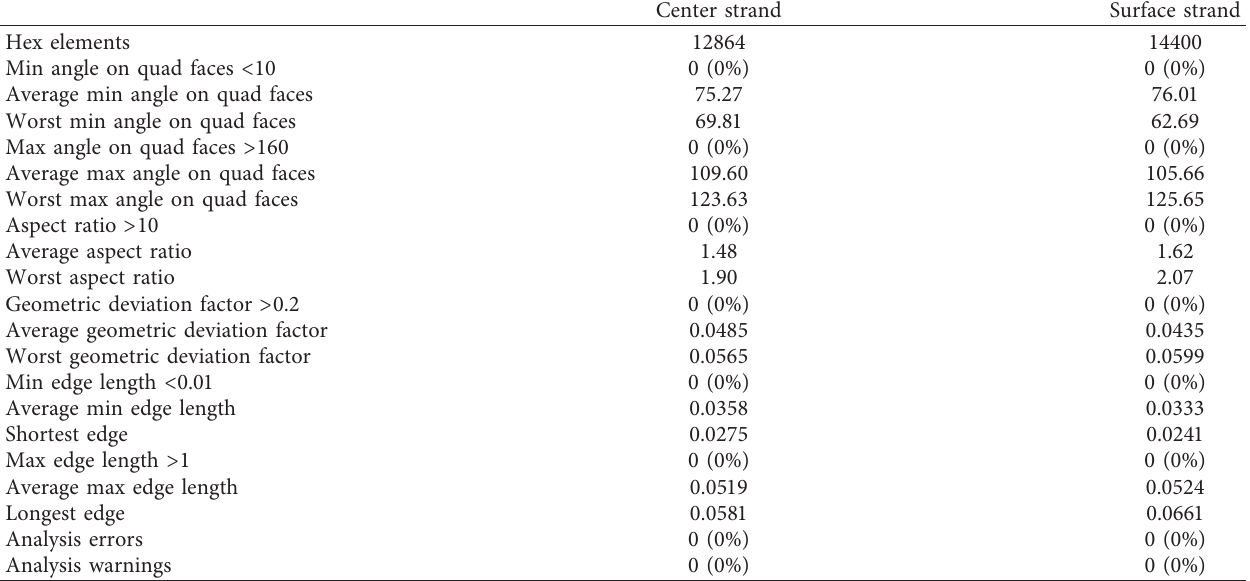
Table 1: Mesh quality analysis.